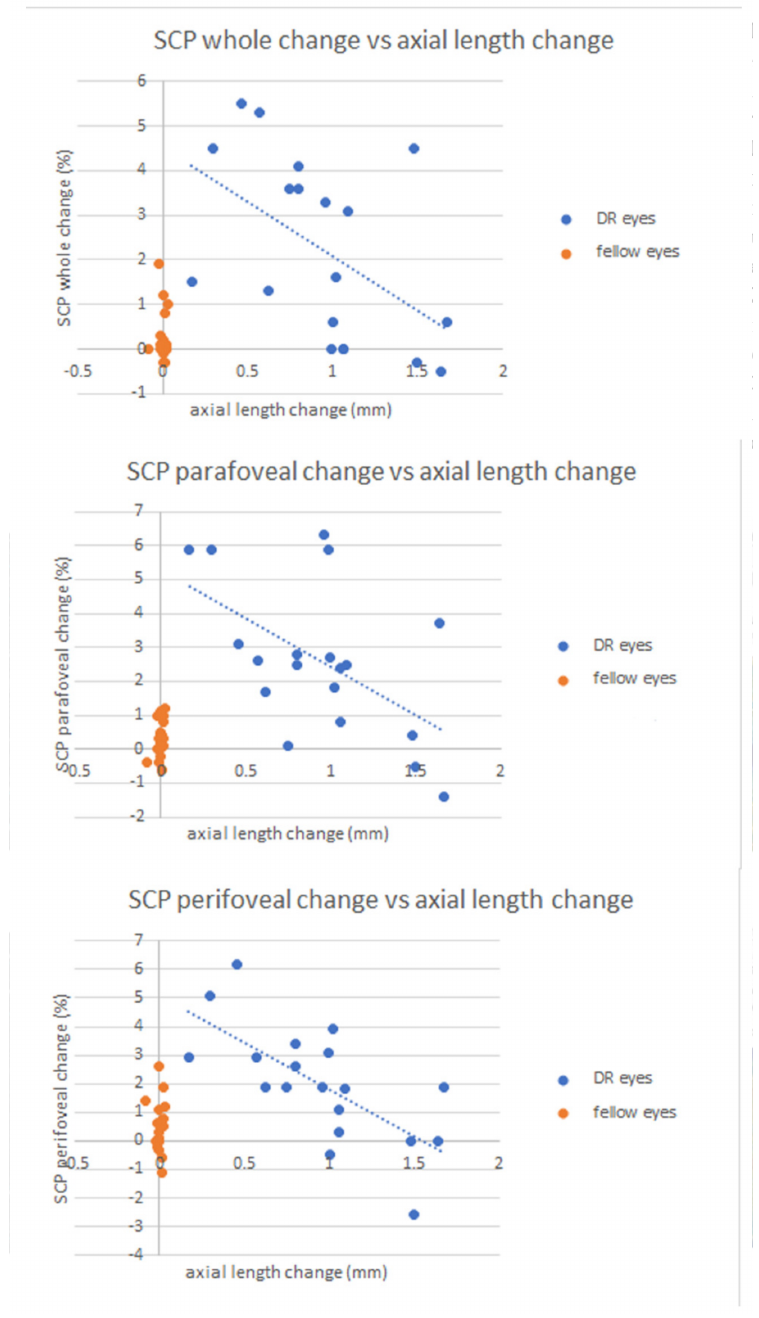
Figure 2. Scatterplots illustrating correlation analysis in the macula-on group between axial length change and vessel density change in the whole parafoveal and perifoveal superficial capillary plexi (SCP). Blue dots represent retinal detachment eyes (DR eyes), while orange dots represent fellow